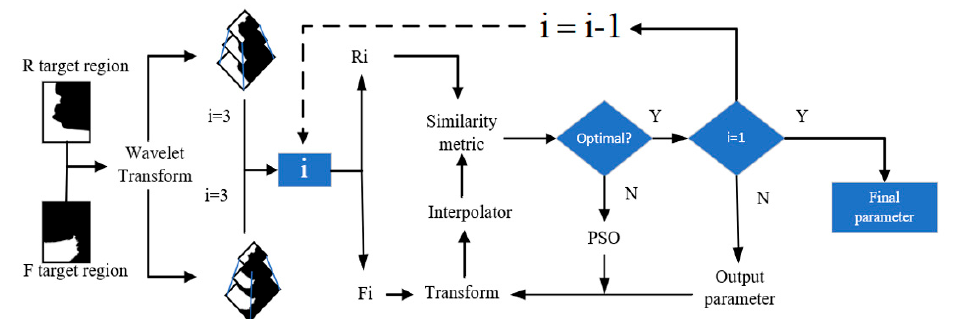
Figure 7. Image registration flow chart.